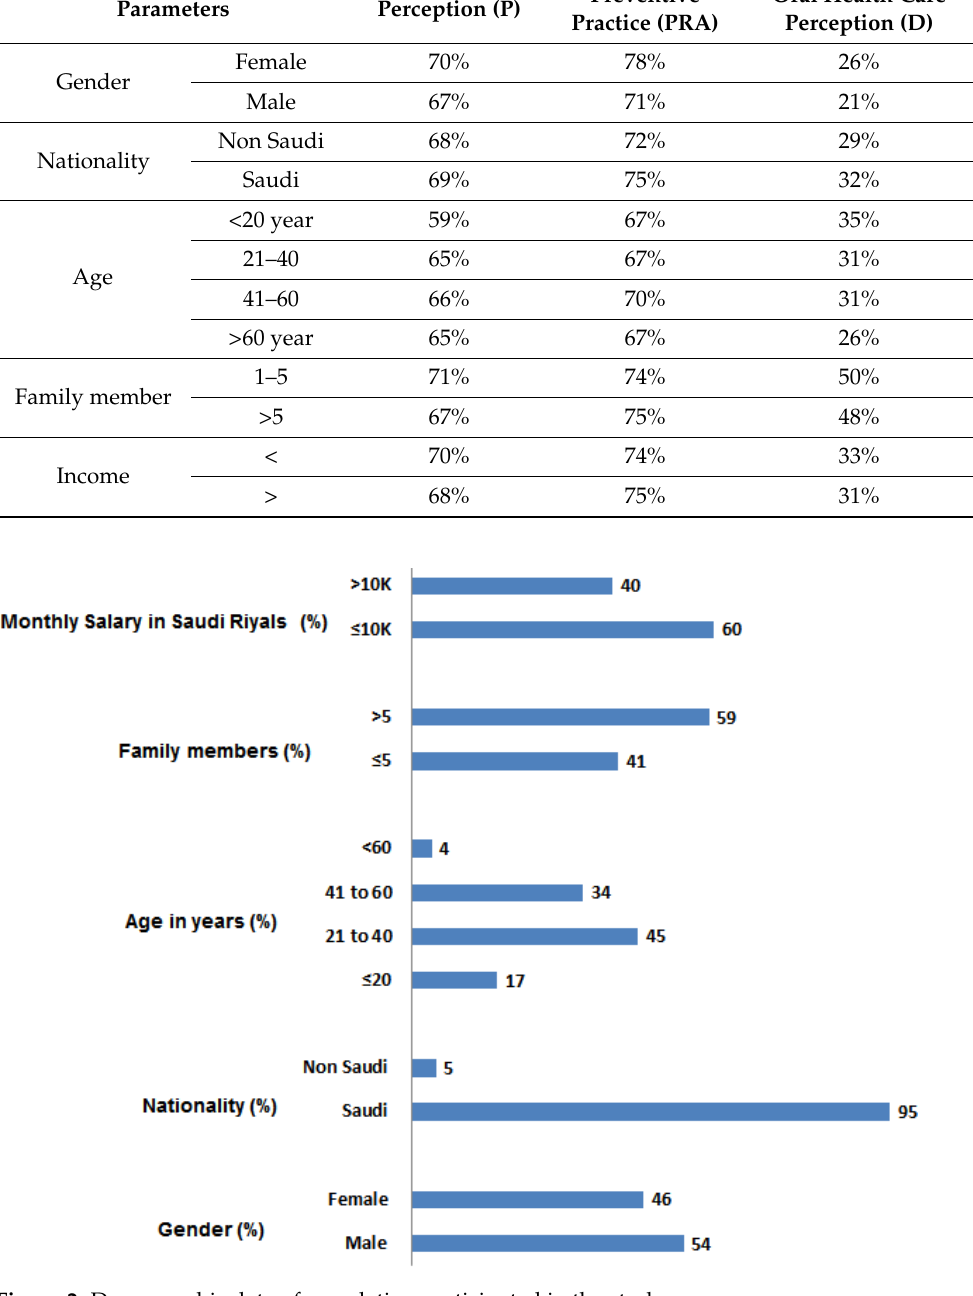
Figure 2. Demographic data of population participated in the study.